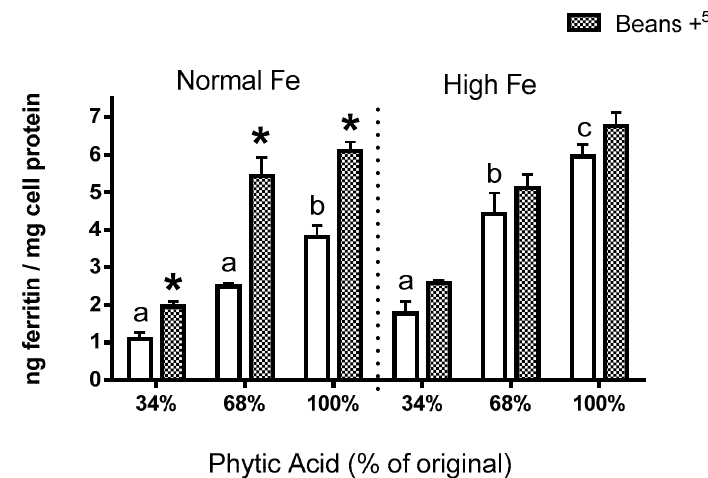
Figure 2. Experiment 3. Caco-2 cell Fe uptake as measured by ferritin formation from normal and high Fe beans that were extrinsically labelled with 58 Fe as per a published human study using the same harvest of these bean varieties [9]. Values are mean ± SEM, n = 3. Bars with no letters in common indicate significant difference ( p < 0.05). Asterisks indicate significantly more ferritin formation relative to samples without the 58 Fe label.